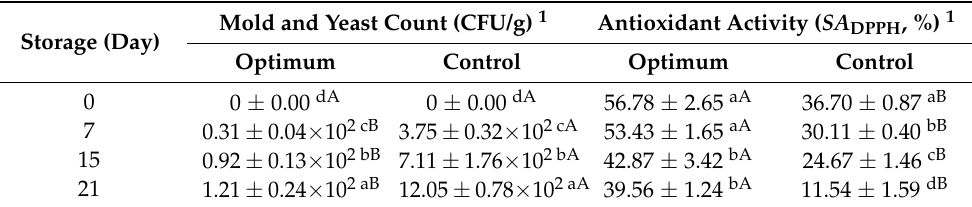
Table 6. Cold storage-dependent antifungal and antioxidant activities of optimal yogurt gels supple- mented with TEO-NEs compared to the optimal